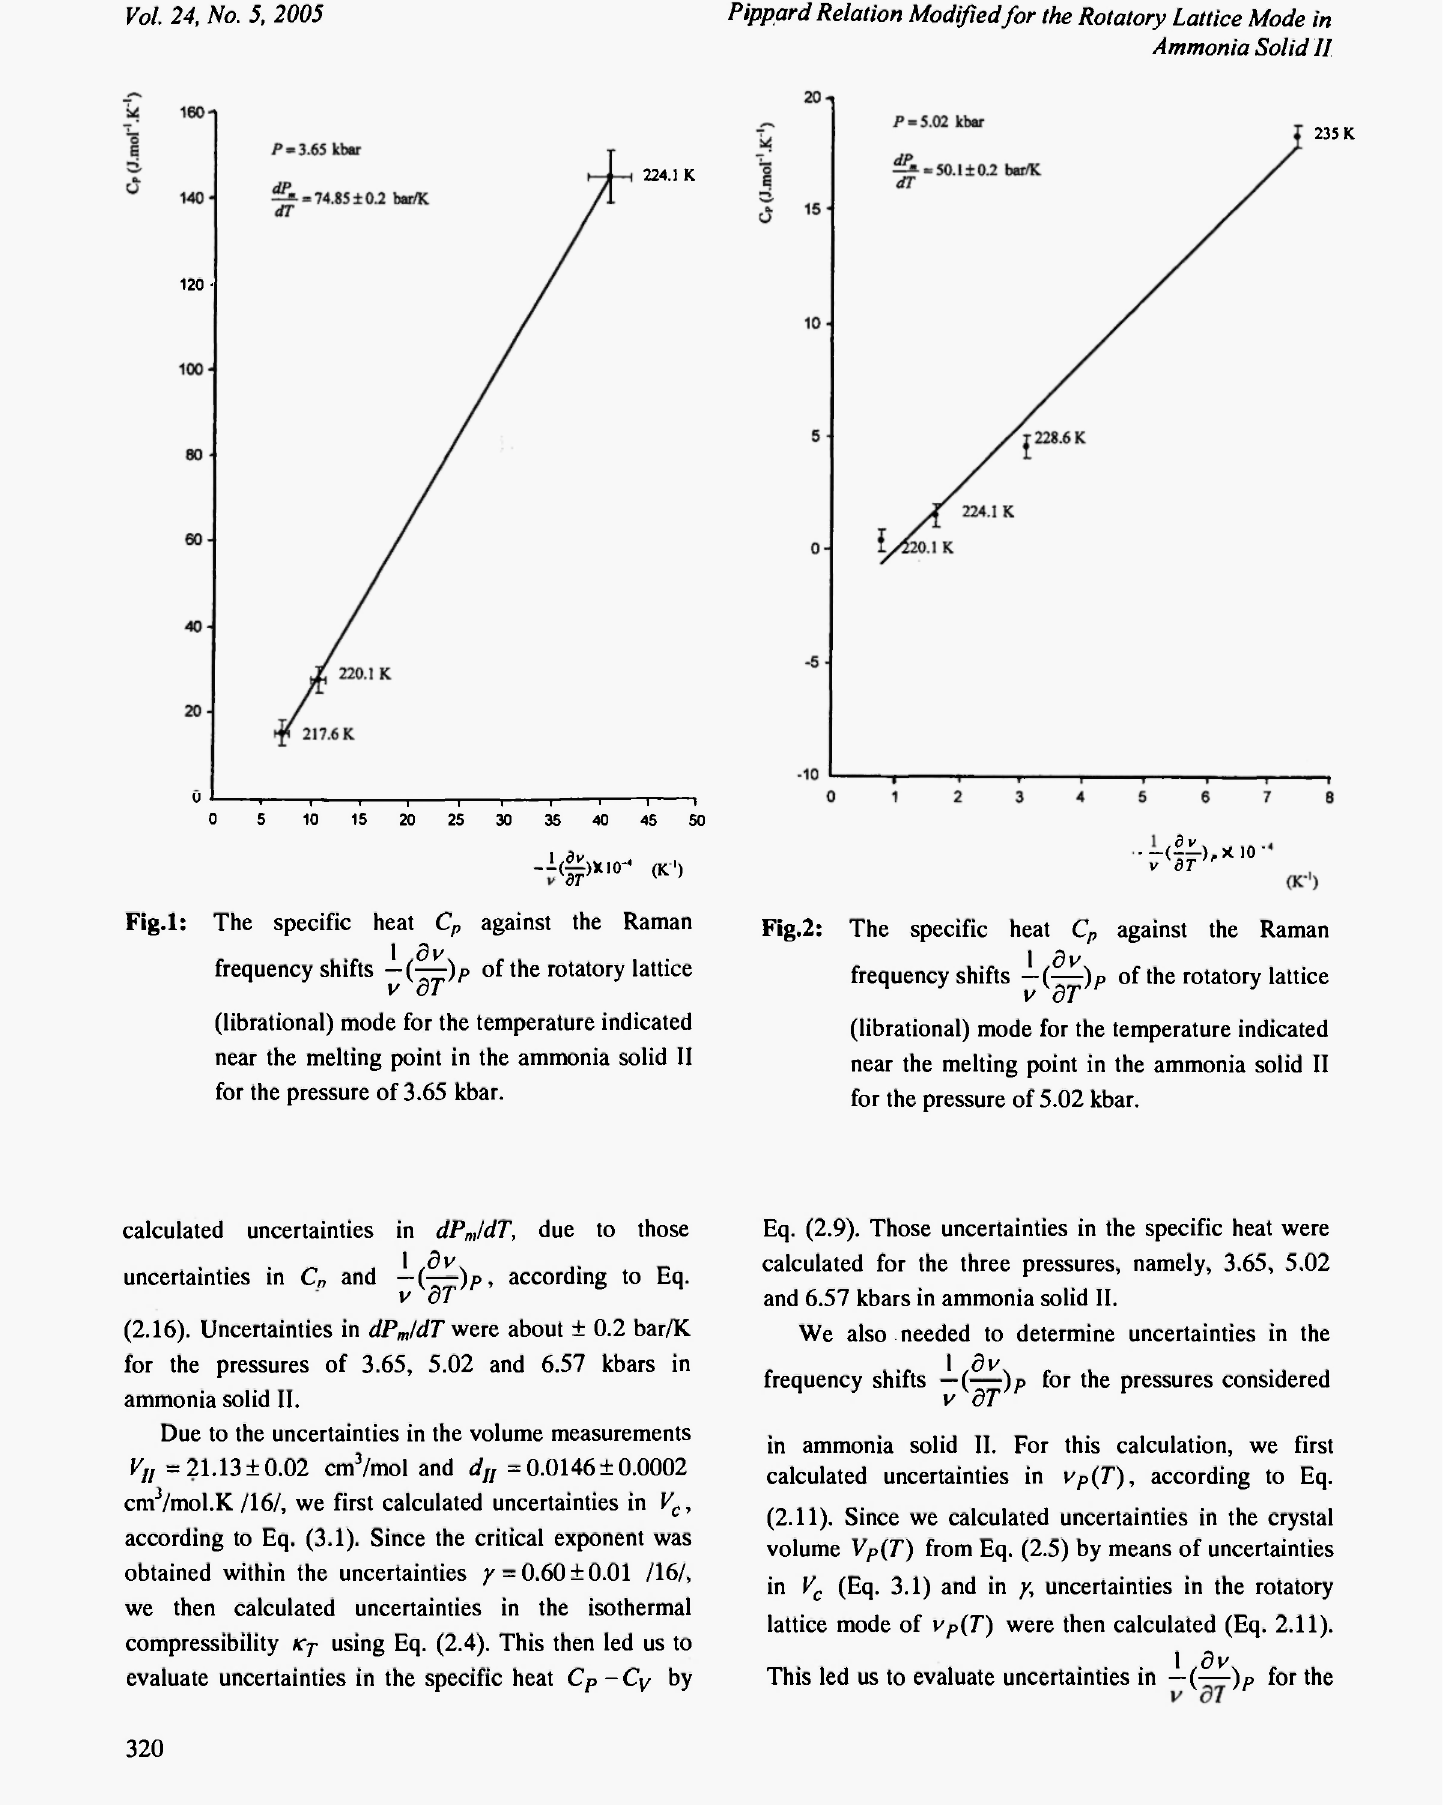
Fig.2: The specific heat C p against the Raman 1 dv frequency shifts — ( — ) P of the rotatory lattice ν dT (librational) mode for the temperature indicated near the melting point in the ammonia solid II for the pressure of 5.02